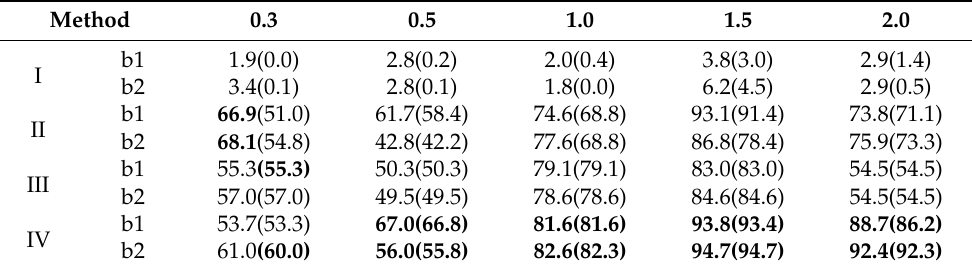
Table 1. SFSE (single-frequency single epoch) ambiguity fixing rate and correct fixed rate of various designed and actual baseline lengths (GPS-only observations, open sky), LAMBDA (approach I), CLAMBDA (approach II), MCLAMBDA (approach III) and CLAMBDA-search (approach IV). The column in the table is the designed baseline length.